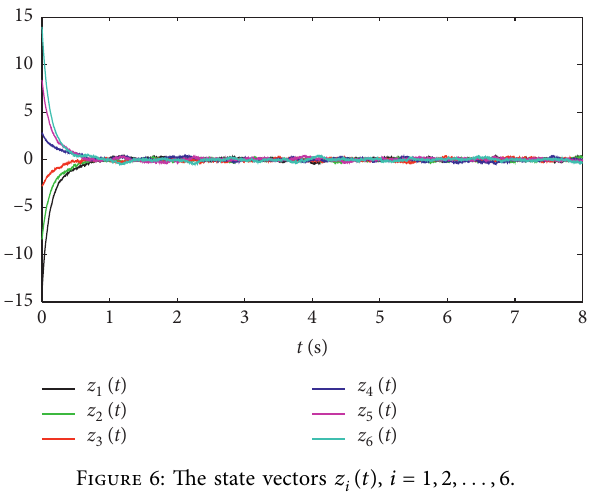
Figure 6: The state vectors z